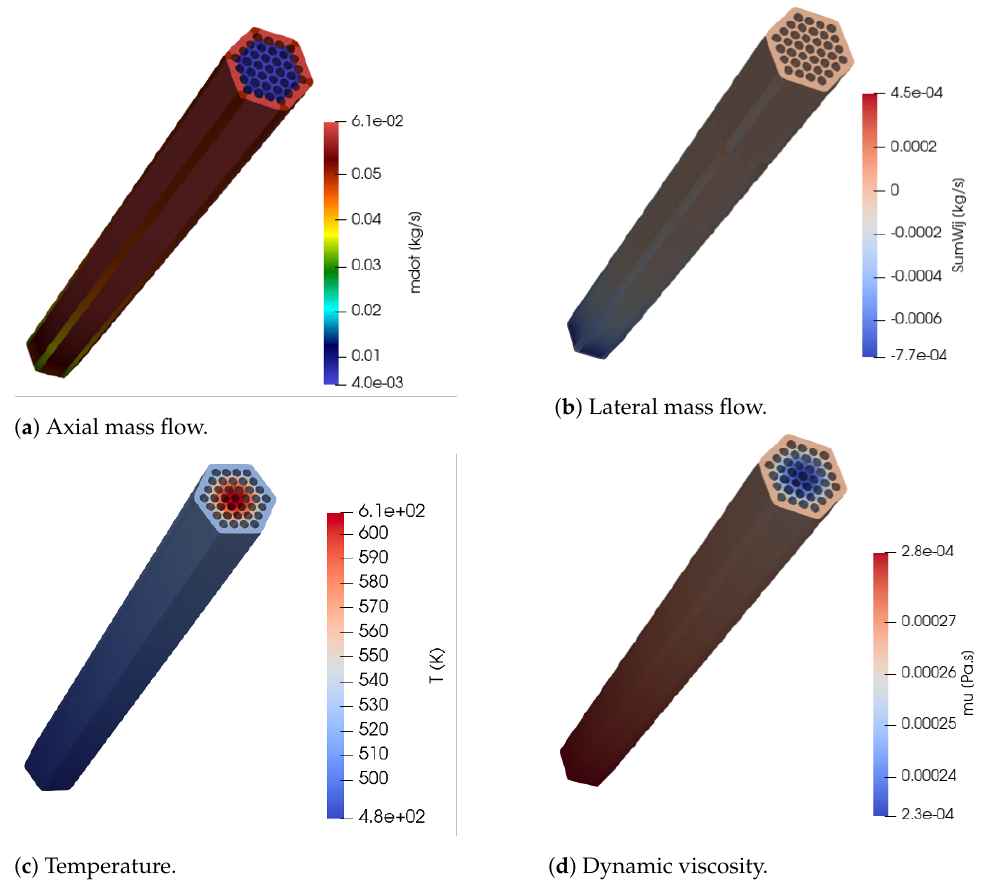
Figure 9. Example of simulation results for the high flow test case in the Toshiba 37-pin bench- mark. ( a ) Distribution of axial mass flow. ( b ) Distribution of lateral mass flow. ( c ) Distribution of temperature. ( d ) Distribution of dynamic viscosity due to